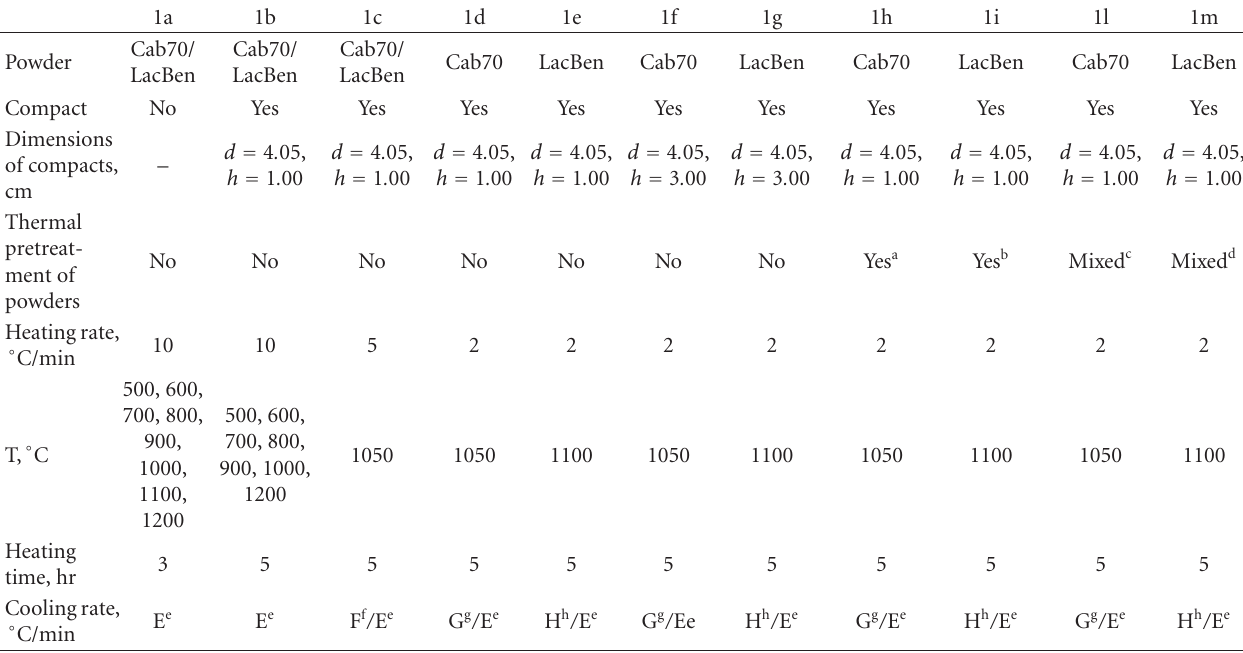
Table 1: Synoptic table of performed thermal